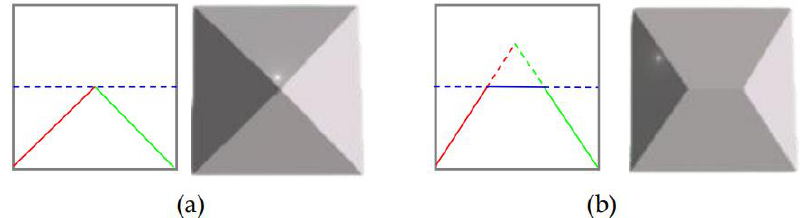
Figure 6. Illustration of edges intersection. ( a ) the intersection of two line segments; ( b ) the intersection of three line segments.